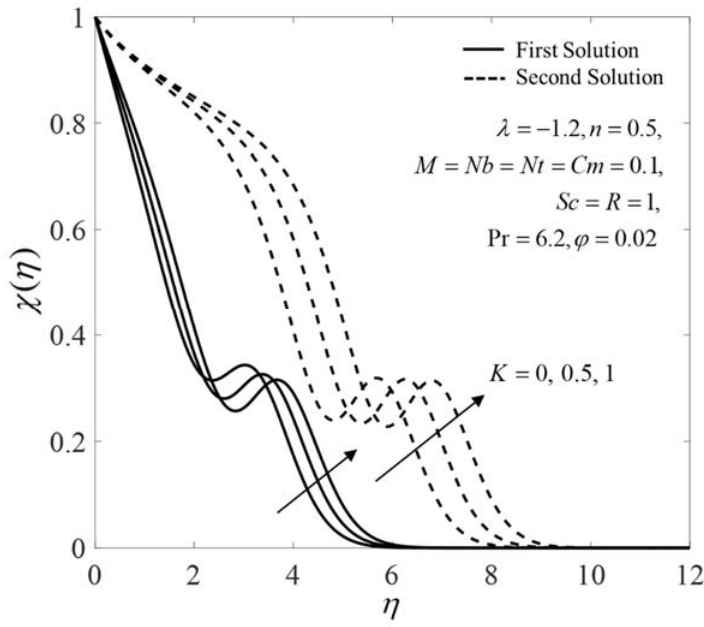
Figure 11. The plot of χ ( η ) for different K values.